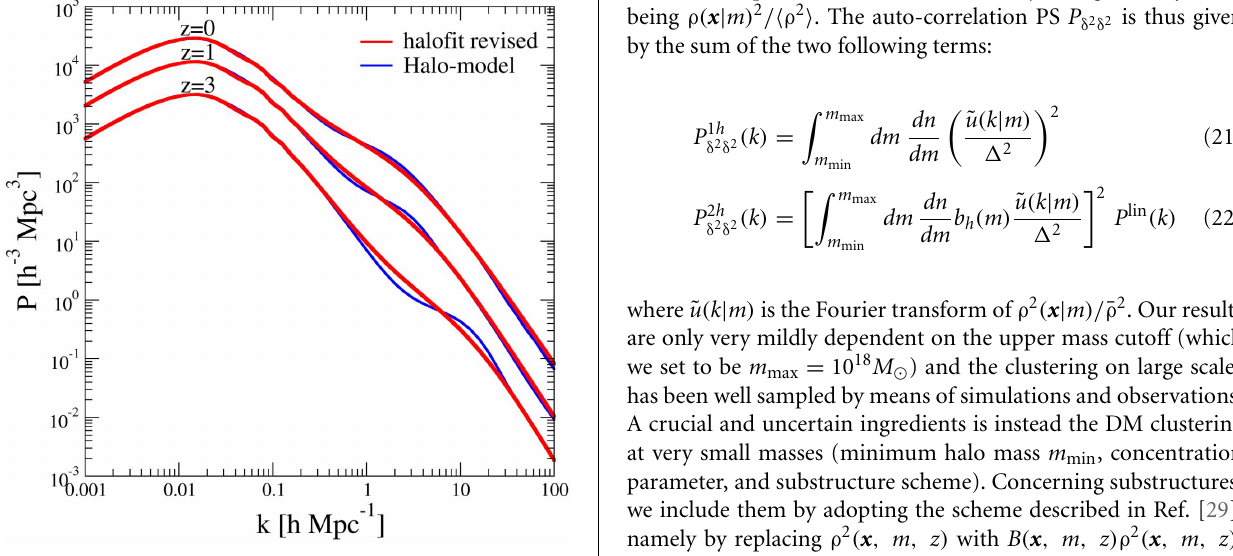
FIGURE 1 | 3D power spectra. Comparison between the non-linear 3D matter-PS obtained with the halo-model considered in this paper and the revised halofit results from high-resolution N -body simulations presented in Ref. [27], at different